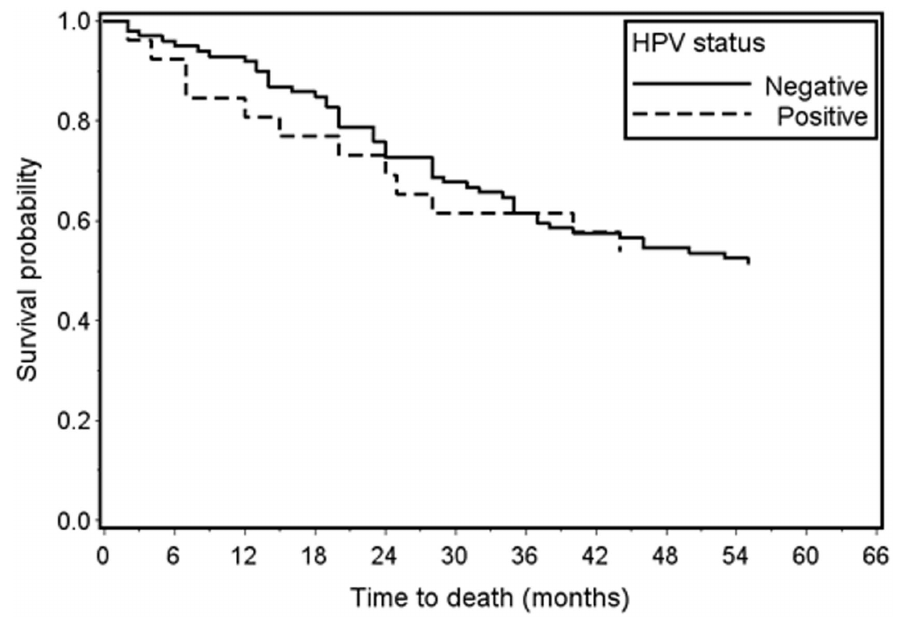
Fig. 2. Overall 5-year survival in laryngeal cancer cases by HPV status (Log-rank P -value 5 0.88; HPV + n 5 26; HPV 2 n 5 100).